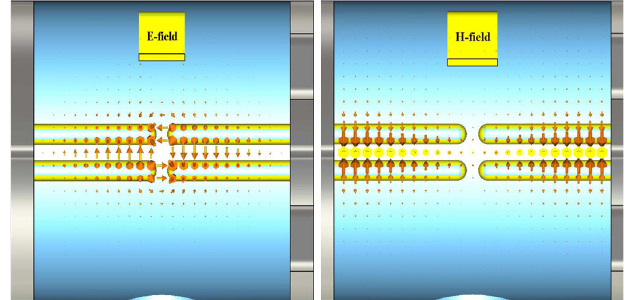
~E; ~H Þ distribution in the xz